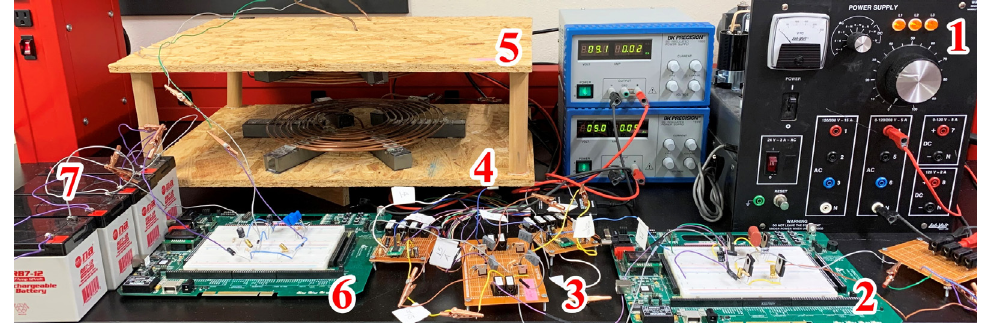
Figure 16. Lab-scale prototype of dynamic wireless charging for EV battery; 1: AC Power Supply, 2: Transmitter Rectifier, 3: GaN Inverter with its gate drivers, 4: Transmitter Coil, 5: Receiver Coil, 6: Receiver Rectifier, and 7: Batteries.